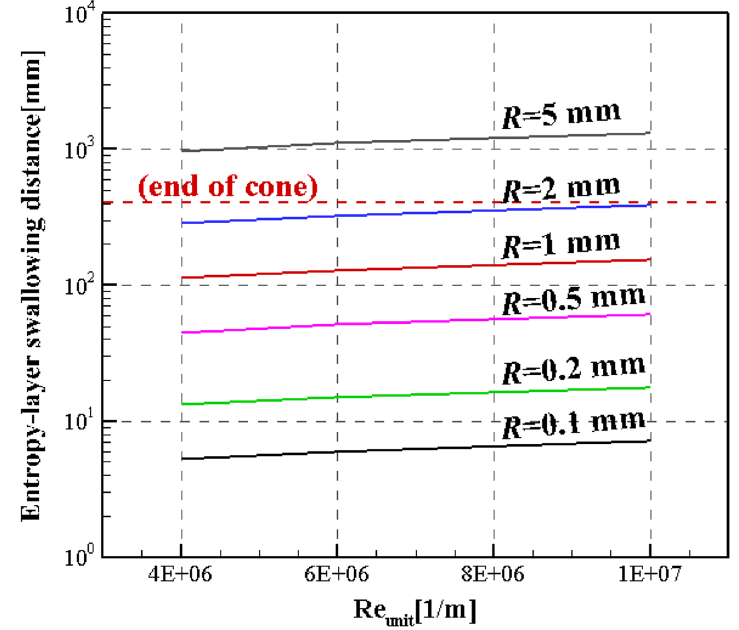
Fig. 5 Entropy-layer swallowing distance x sw along 7-degree half angle slender cone